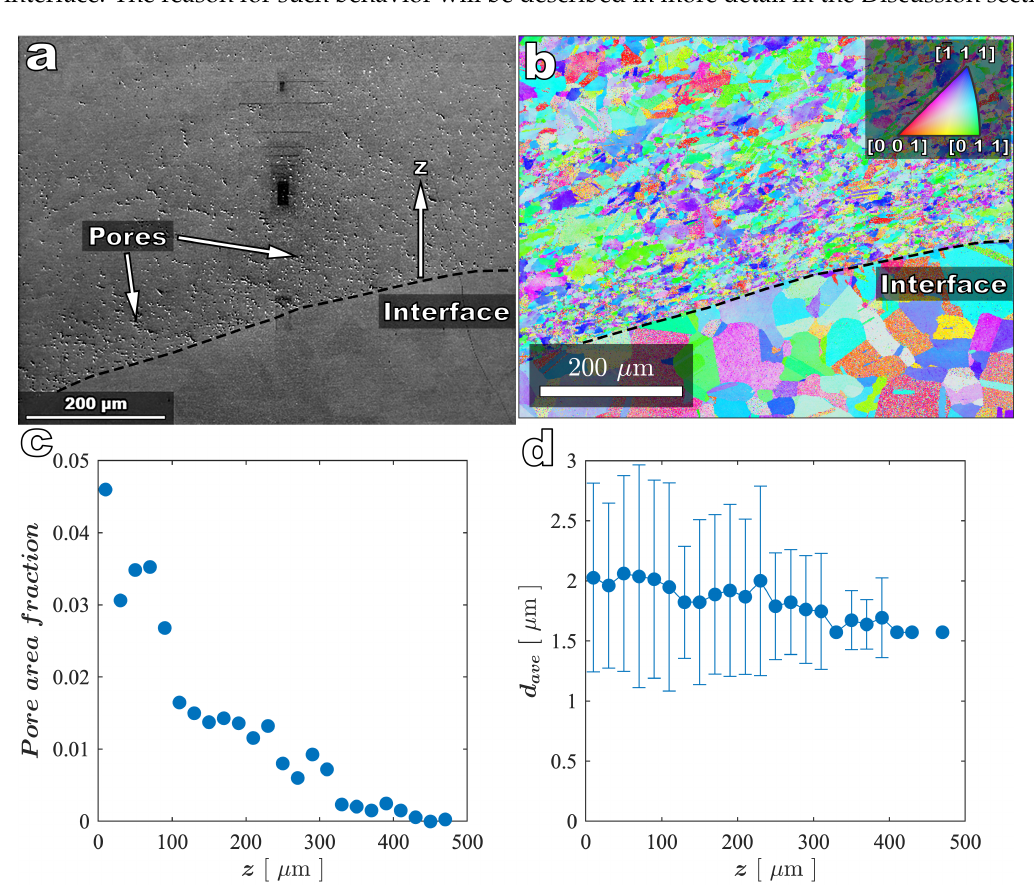
Figure 2. Microstructural evaluation of the substrate–deposit interface by scanning electron microscopy. ( a ) contains a secondary electron image of the substrate–deposit interface; the approximate location of the interface is marked with a dashed line. The coordinate axis z denotes distance from this interface into the deposit. ( b ) is an inverse pole figure map of the approximate region represented in ( a ). The interface is again marked with a dashed line, and the color scheme is shown in the inset at the top right. ( c ) shows the pore area fraction determined from ( a ) as a function of distance from the interface, z. ( d ) plots the average pore size as a function of distance from the interface, z. Error bars may be either omitted for z ranges having only one data point or obscured by the average value marker (filled